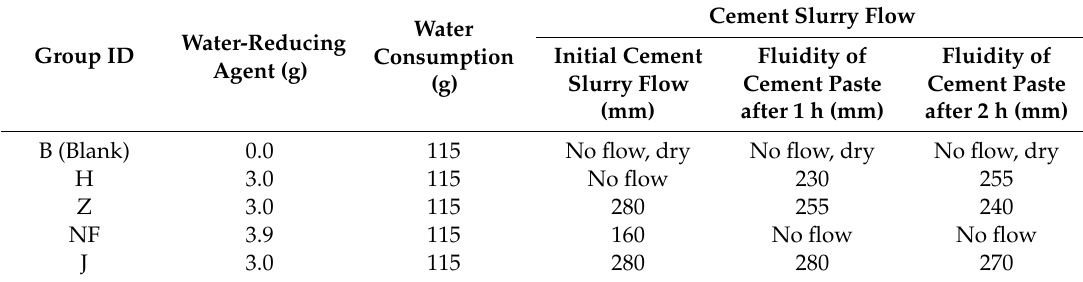
Table 4. E ff ects of functional polycarboxylic acid superplasticizers on the flow performance of the cement paste.